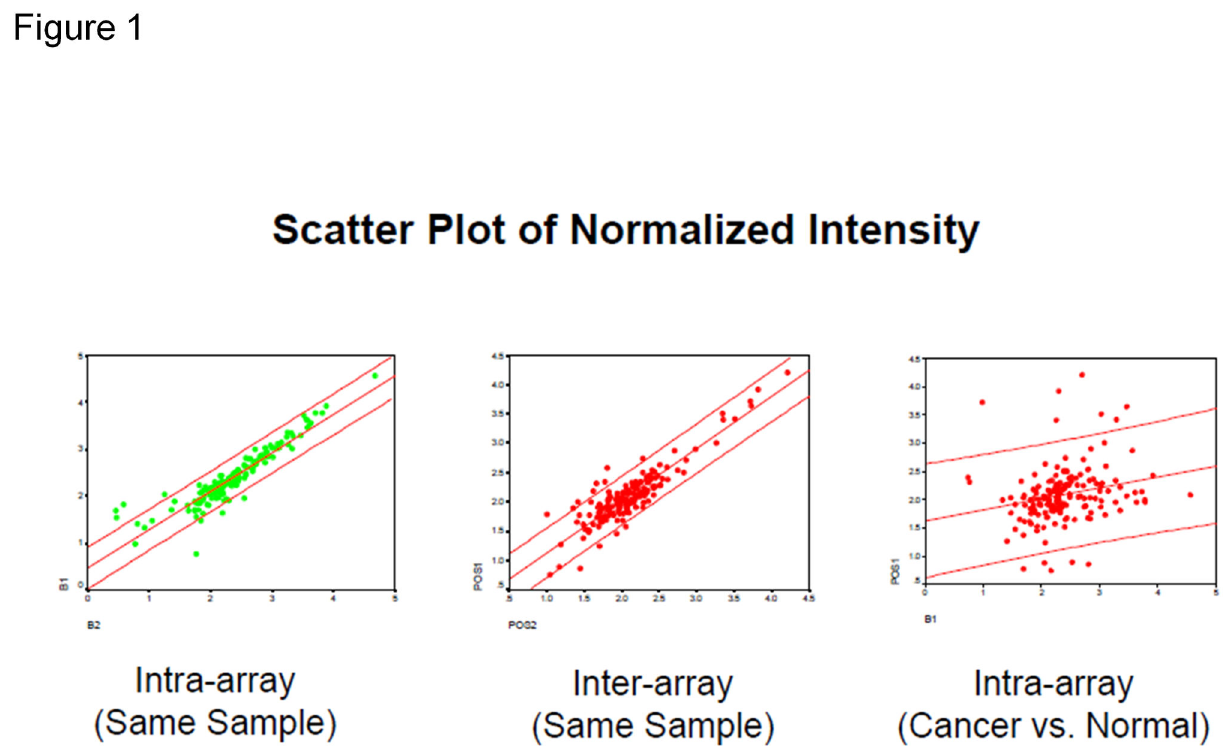
Figure 1. Scatter plot for normalized intensity of 174marker antibody arrays. Panel A (left) shows strong intra-assay correlation (same sample assayed on the same glass slide, tested on the same day); Panel B (middle) shows strong inter-assay correlation (same sample assayed on different glass slides, tested on different days); Panel C (right) shows poor correlation between cancer and normal samples assayed on the same glass slides, tested on the same day. doi: